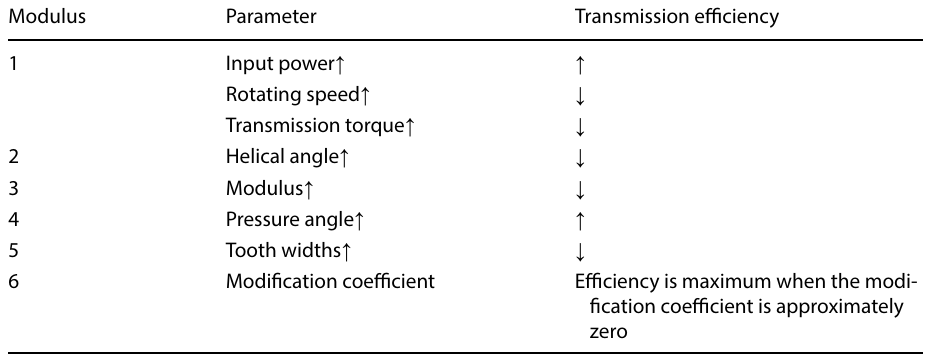
Table 2 The influence of various parameters on transmission